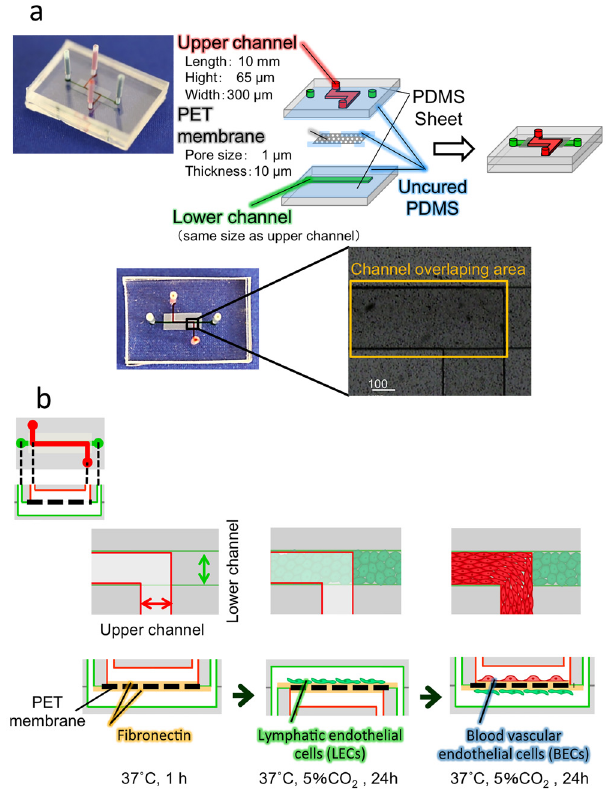
Fig 1. Experimental design. (a) Schematic of a membrane-integrated microfluidic device. (b) Experimental procedure used for coculturing BECs (cells in red) and LECs (cells in green) on opposite sides of the membrane in the microfluidic